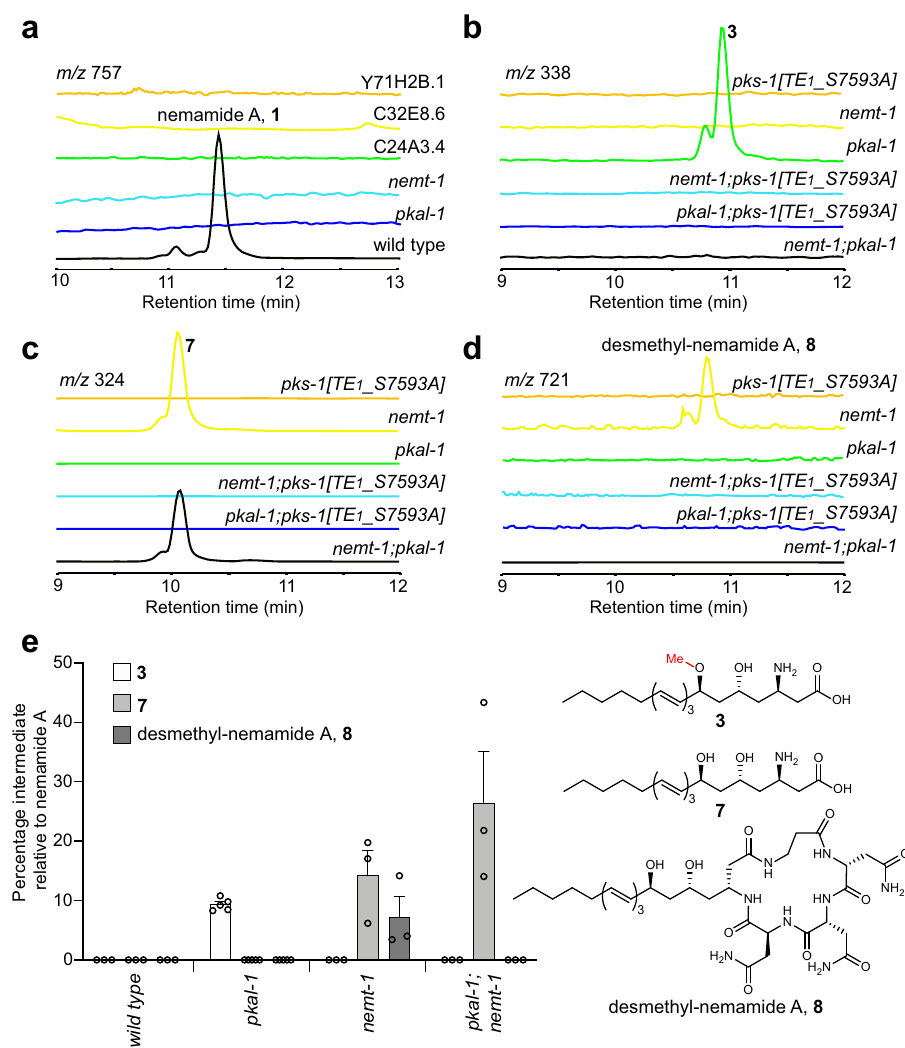
Fig. 4 Analysis of nemamides and biosynthetic intermediates in mutant strains in which trans -acting enzymes have been inactivated. a – d Representative extracted ion chromatograms of nemamide A, 1 , ( a ) in mutant strains for the trans -acting enzymes and intermediate 3 ( b ), intermediate 7 ( c ), and desmethyl-nemamide 8 ( d ) in the pks-1(reb11[TE 1 _S7593A]) , pkal-1(reb28) , nemt-1(reb15) , and double mutant strains. e The amounts of intermediates 3 , 7 , and 8 in mutant strains relative to the amount of nemamide A in wild-type worms were based on the UV absorbance of the compounds and were normalized by the total mass of dried worms used for extraction. Data in ( e ) represent the mean ± SEM, n = 5 independent experiments for pkal-1 mutant and n = 3 independent experiments for wild type and other mutants. Source data are provided as a Source Data fi